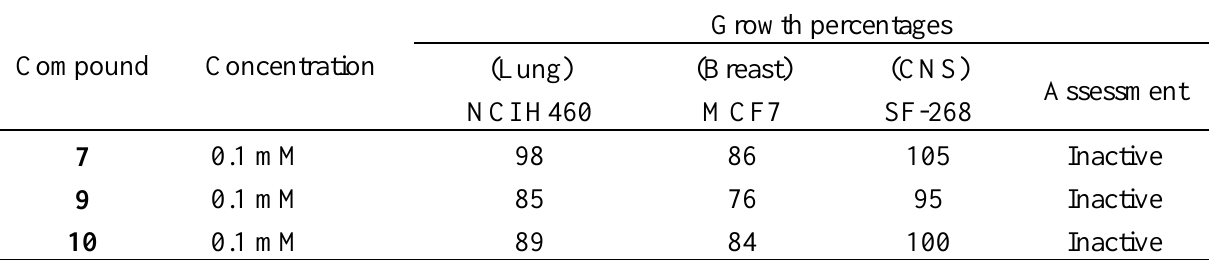
Table 3. Antitumour activity of selected quinoxalines 7 , 9 and 10 in